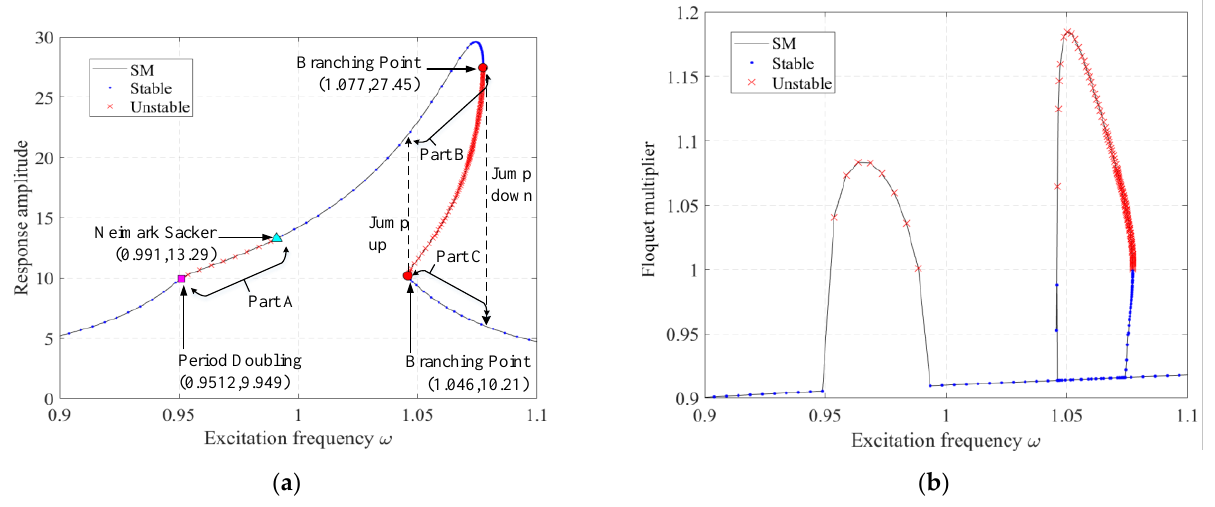
Figure 7. Amplitude – frequency characteristics, stability, and bifurcation points of the system with gap = 10: ( a ) amplitude – frequency curves; ( b ) Floquet multipliers.